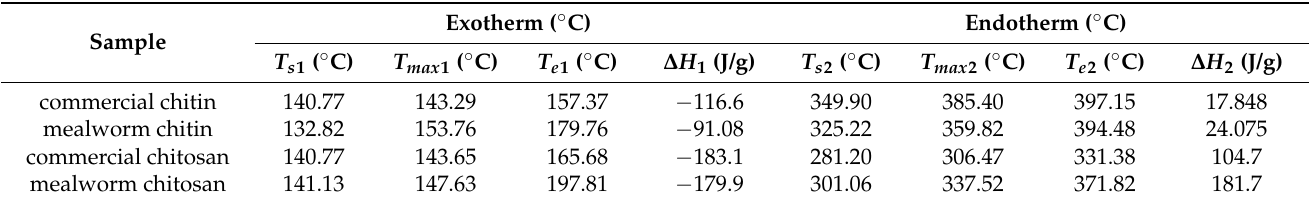
Table 2. DSC of commercial chitin, mealworm chitin, commercial chitosan, and mealworm chitosan.